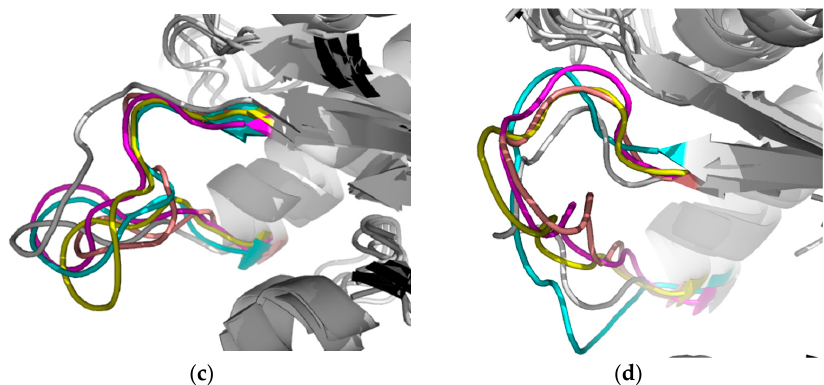
Figure 7. Catalytic loop 6 dynamics in ( a ) Apo-TbTIM; ( b ) TbTIM- 1 ; ( c ) TbTIM- 2 ; and ( d ) TbTIM- 3 . Cluster 1 (gray), Cluster 2 (cyan), Cluster 3 (magenta), Cluster 4 (yellow) and Cluster 5 (pink). The alignments were made based on backbone.